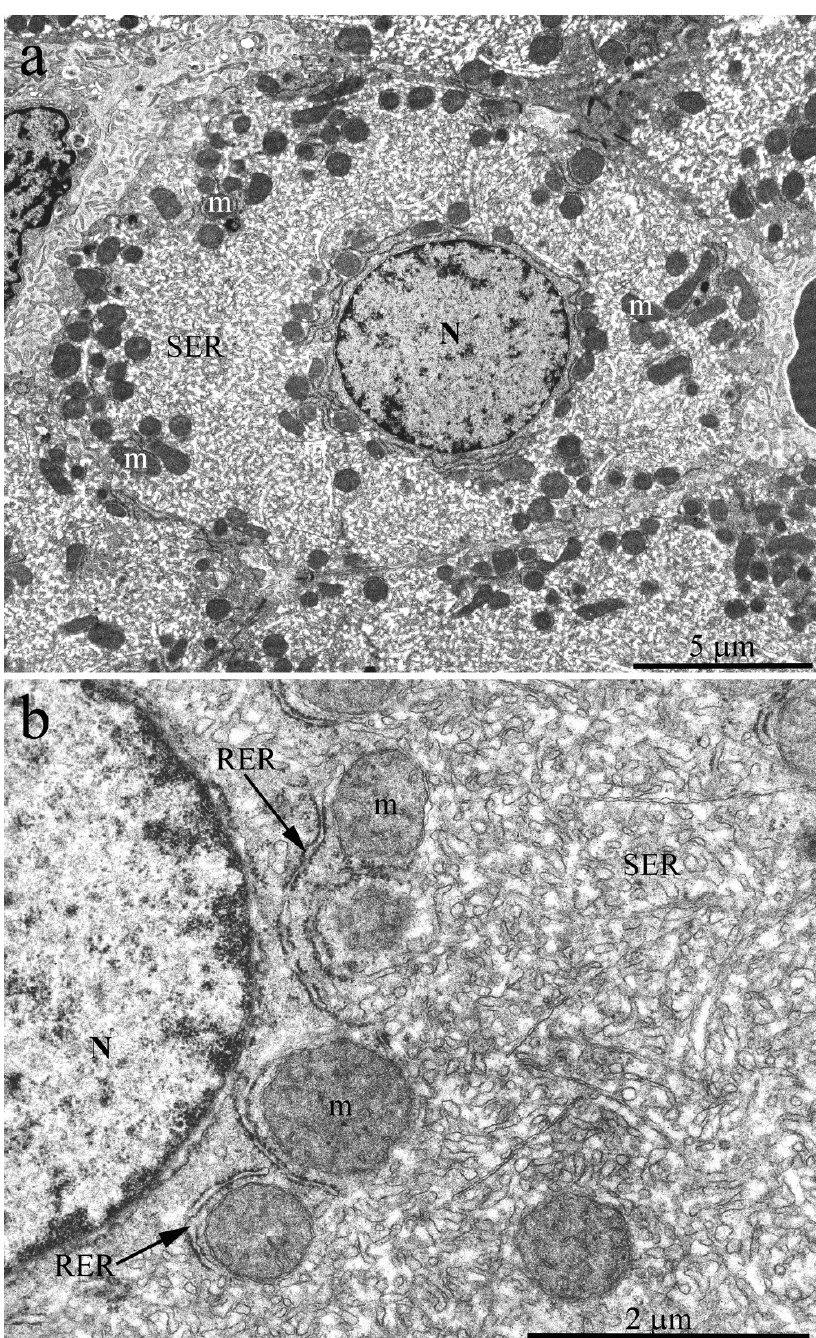
Figure 3. Hepatocyte ultrastructure of H. glaber aged 3 years. ( a ) Overview photograph. The nucleus (N) is located in the center of a polygonal cell. Numerous rounded or oval-shaped mitochondria (m) are located around the nucleus and on the periphery of cells. The rest of the internal hepatocyte space is densely filled with SER membranes; ( b ) Features of the internal hepatocyte ultrastructure. Most of the cytoplasm is densely filled with SER membranes, represented by a system of tubules and cisterns. RER is located mainly around the mitochondria (m). On its outer membrane there are numerous osmiophilic granules of 12–15 nm in diameter, i.e., ribosomes.